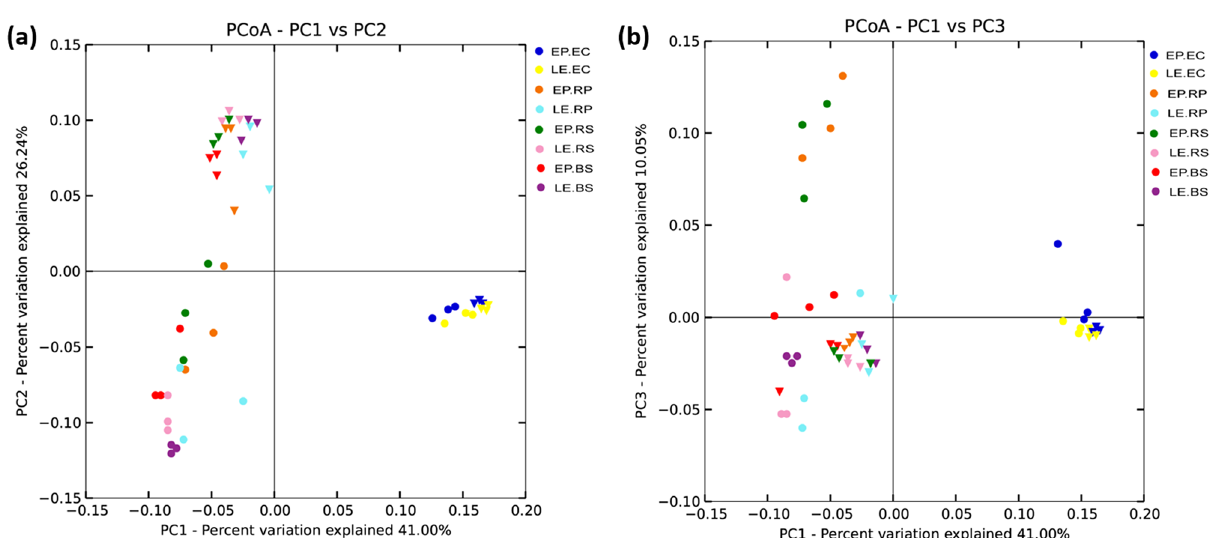
Figure 5. β-diversity analysis using PCoA that represents microbial separation depending upon, three rhizo- compartments i.e. endophytic compartment/endosphere (EC), rhizoplane (RP), rhizosphere (RS); soil type i.e. Nanjing campus (NC), peat potting (PP); and plant species i.e. E. plantagineum (EP), and L. erythrorhizon (LE). Object shape represents soil type; circle (PP), triangle (NC). Color represents different rhizo-compartments. Each circle/triangle represents one replicate, while each sample has 3